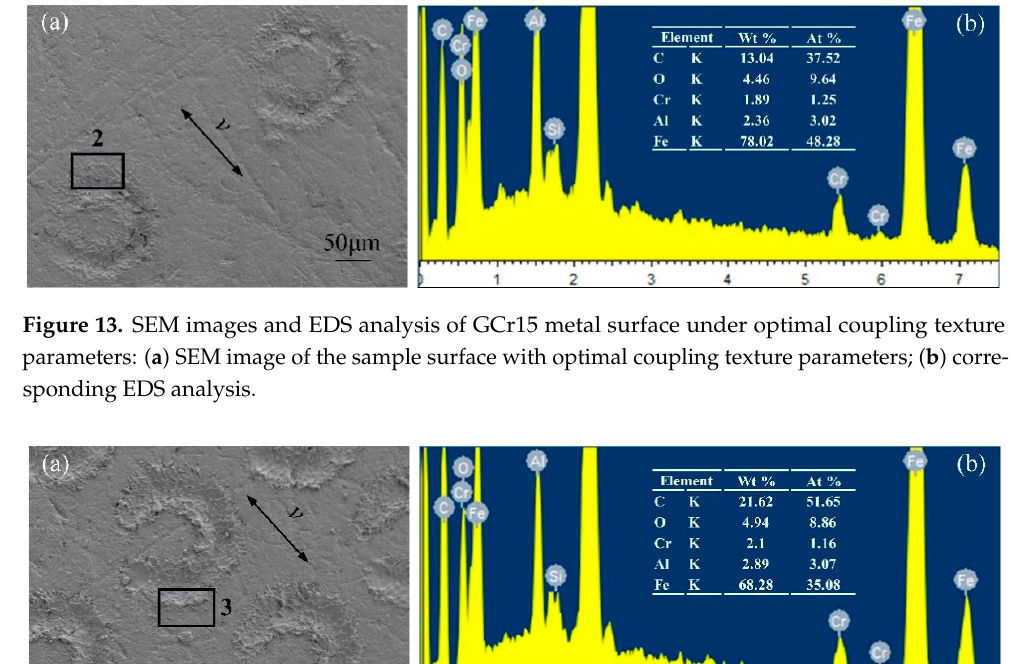
( a ) SEM image of untextured sample surface; ( b ) corresponding EDS analysis.